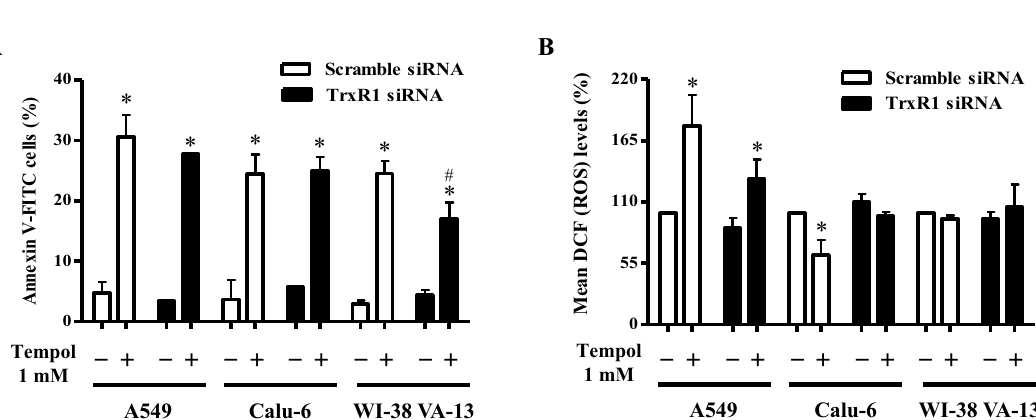
Figure 6. Effects of TrxR1 siRNA on cell death and ROS levels in Tempol-treated lung cancer and normal cells. Cells (approximately 40–50% confluence) were transfected with control scramble siRNA or TrxR1 siRNA. One day later, cells were treated with 1 mM Tempol for 48 h. ( A ) Annexin V-FITC positive cells were evaluated with a FAC Star flow cytometer. Graph shows proportions of annexin V-positive cells in A549, Calu-6, and WI-38 VA-13 cells. ( B ) Intracellular ROS (DCF) levels in the tested lung cells were measured using a FAC Star flow cytometer. Graph indicates mean ROS (DCF) levels (%) in A549, Calu-6, and WI-38 VA-13 cells. *p < 0.05 compared with untreated controls. #p < 0.05 compared with scramble siRNA-transfected and Tempol-treated WI-38 VA-13